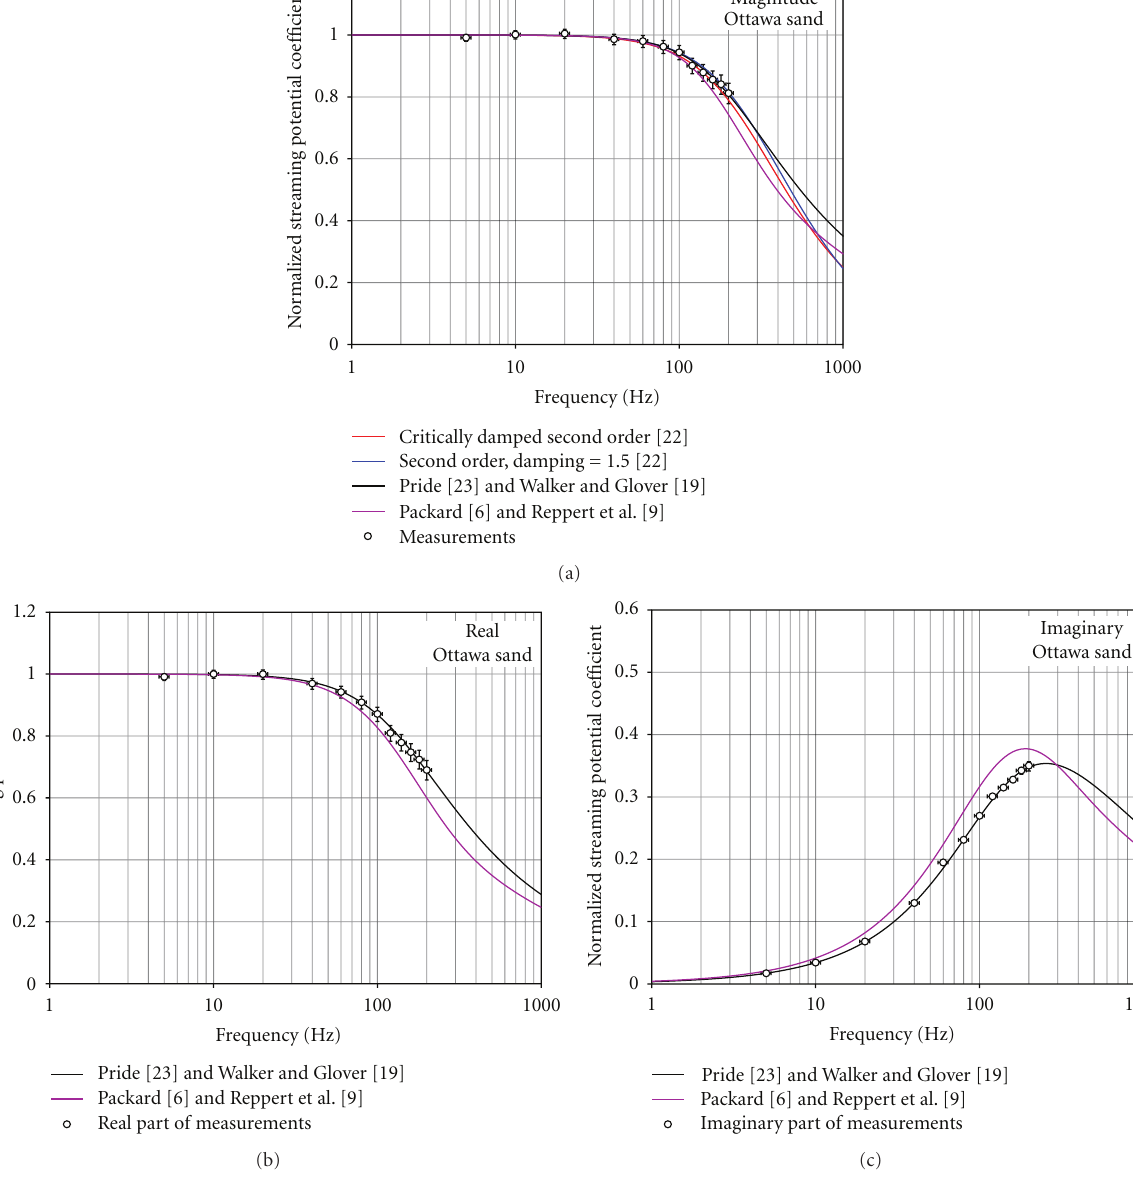
Figure 3: The calculated streaming potential coupling coe ffi cient (normalised to the value at 5Hz, which was 0.518 V/MPa) as a function of frequency for Ottawa sand saturated with 10 − 3 mol/L NaCl solution at 24 ◦ C ( φ = 0 . 325, κ 10 = 1 . 19 × 10 − 10 m 2 ). (a) Magnitude with six models shown fitting the data [6, 9, 19, 22, 23], (b) real component for models [6, 9, 19, 23], and (c) imaginary component for models [6, 9, 19,